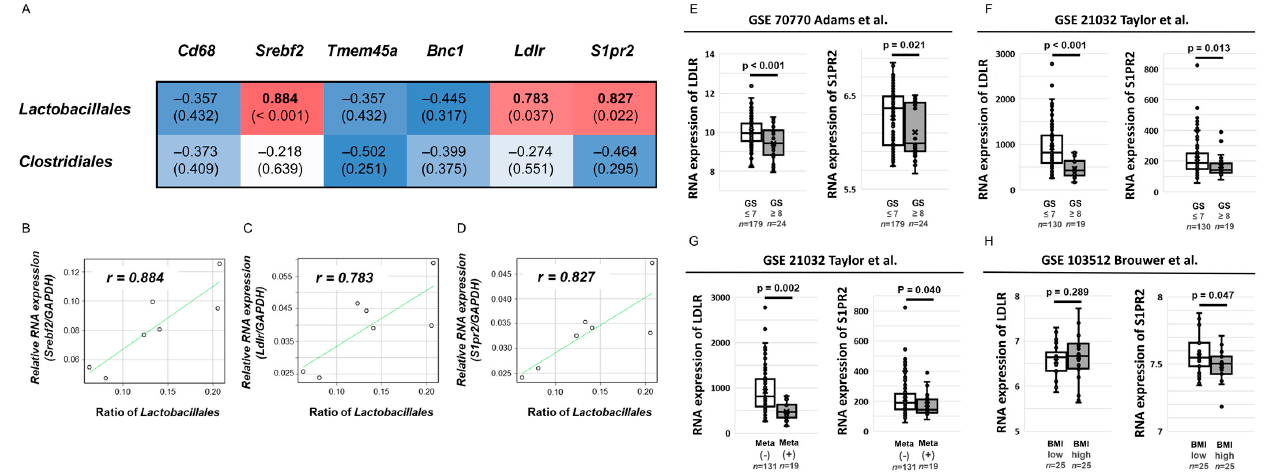
Figure 5 . Correlation between the proportion of two gut microbial species and candidate genes that